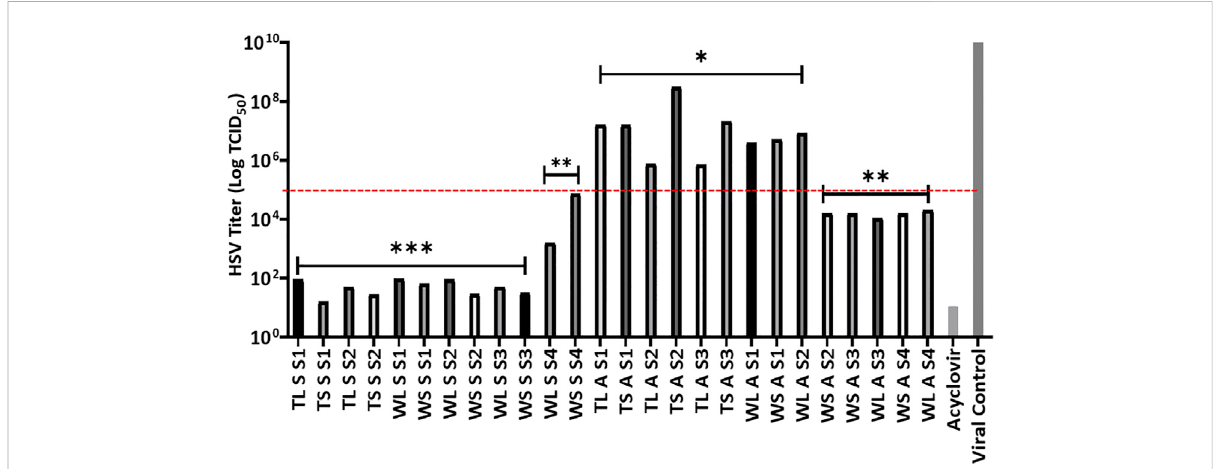
FIGURE 1 Effects of H. aureonitens extracts (leaves and stems) from different sites at two different locations and at two different seasons against HSV tissuecultureinfectionsdose(TCID